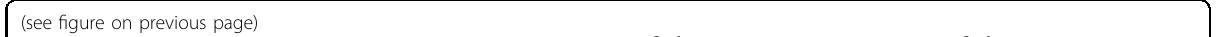
Fig. 4 Increased neuronal loss and lack of glial cell maturation in Fetus m3m4 undergoing gestation in Mom m3m4 compared to those in Mom WT . A Ingenuity pathway analysis showing upregulation of pathways related to neuronal apoptosis and death. B (Upper panel) NeuN staining for mature neurons in fetal brain (representative image of n = 3 Mom WT and n = 6 Mom m3m4 ). (Lower panel) Doublecortin (Dcx) staining for immature neurons in fetal brain (representative image of n = 4 Mom WT and n = 5 Mom m3m4 ). C Serotonin staining in fetuses from Mom m3m4 and Mom WT (representative image of n = 3 each). D IHC for GFAP + astrocytes in fetal brain (Upper panel) periventricular area and (Lower panel) cavum septum pellucidum. E Nanostring glial panel gene expression analysis of the fetal brain. F (Upper Panel) Iba1 staining of fetal brain at E17.5. Insets show traces of typically observed microglia morphology. Quanti fi cation of microglia in fetal brains (Left lower panel) length, (Right lower panel) area ( n = 5 microglia × 2 fi elds from n = 4 – 5 mice). G Integrated density of Iba1 staining on microglia in the fetal brain. Scale bars = 100 µm. Two-tailed t test, * p < 0.05; *** p <